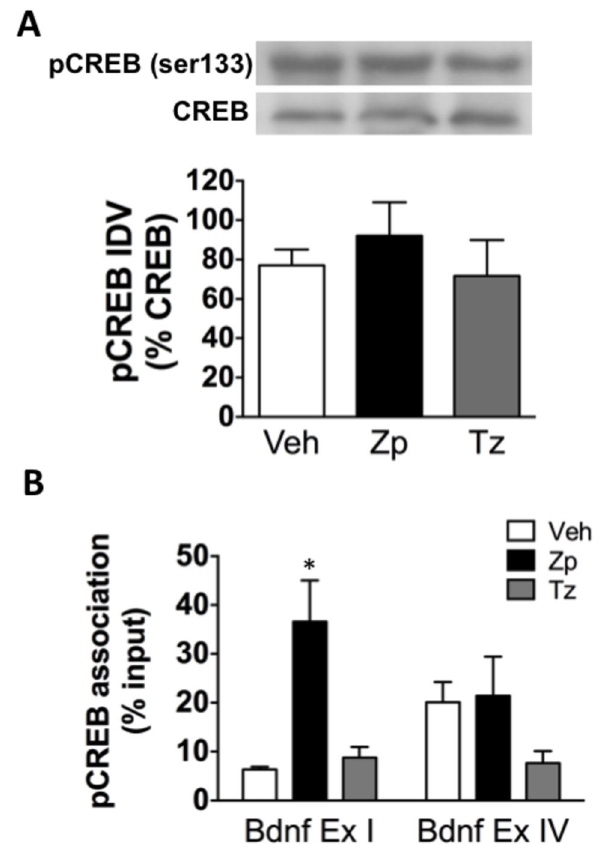
Figure 3. pCREB levels in the HIP following acute BZ treatment. (A) There is no change in total pCREB protein levels in the HIP following BZ treatment as measured by western blots (n= 4); (B) There is a significant increase in pCREB association with BDNF promoter I in the HIP following ZP treatment as measured by ChIP (n= 5-7). * p < 0.05; IDV: integrated density